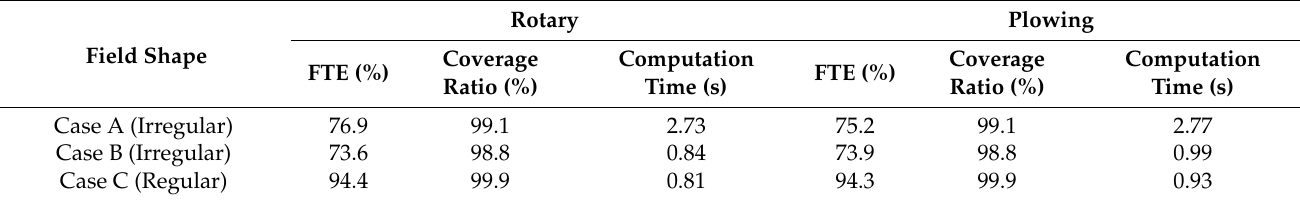
Table 4. Results from X-type turning pattern.